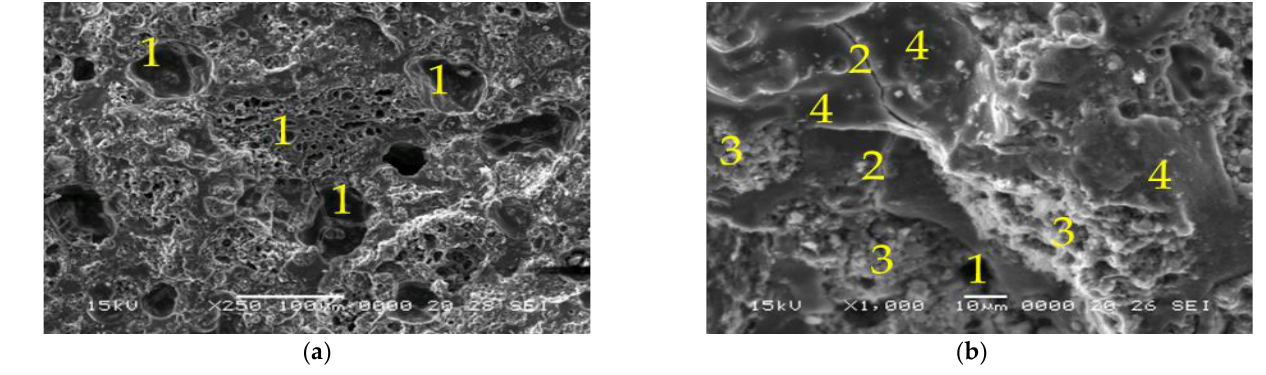
Figure 9. SEM micrographs of: ( a , b ) Sample 8MX1, ×250, respectively, ×1000 magnification (1 — pores, 2 — microcracks, 3 — partially reacted fly ash and 4 — dense zone of reacted fly ash) .